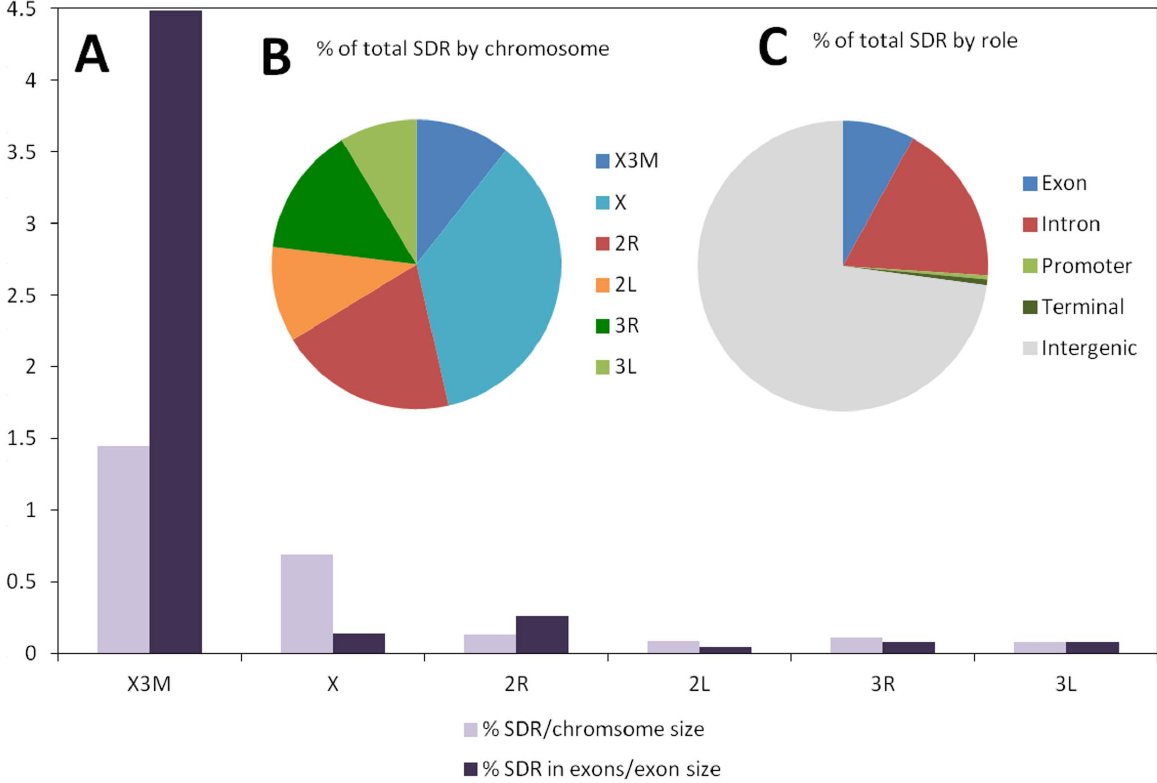
Figure 2. Distribution and characterization of genomic divergence. A: Proportion (%) of significantly differentiated regions (SDRs) expressed as a percentage of the total chromosome segment size are shown in light colored bars. Proportions of SDRs in exons as a percentage of the total exon size per segment are shown in dark colored bars. The X3M segment includes the 3 Mbp region proximal to the centromere. The X includes the X chromosome minus the X3M region. B: Proportion (%) of total SDR size categorized by chromosome segment. C: Proportion (%) of total SDR size categorized by the role of the nearest gene. An SDR is classified as ’intergenic’ if there is no gene located within 250 bp from either end of that SDR.